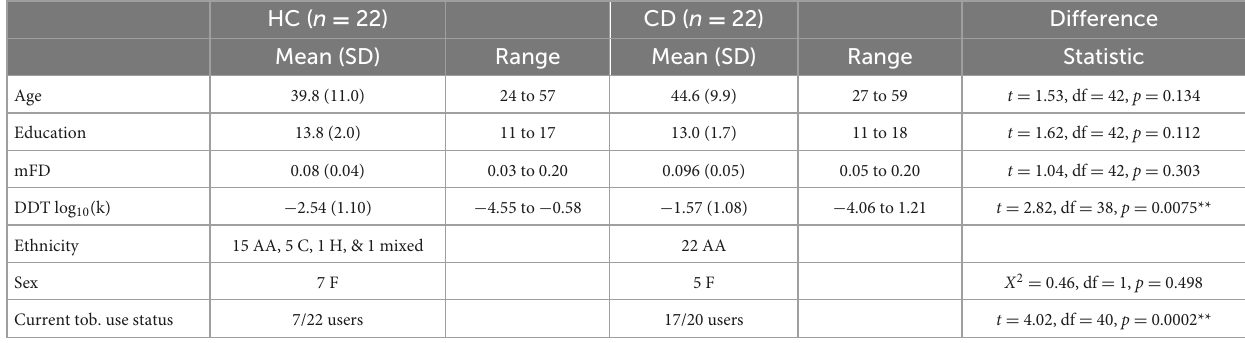
TABLE 1 Demographic